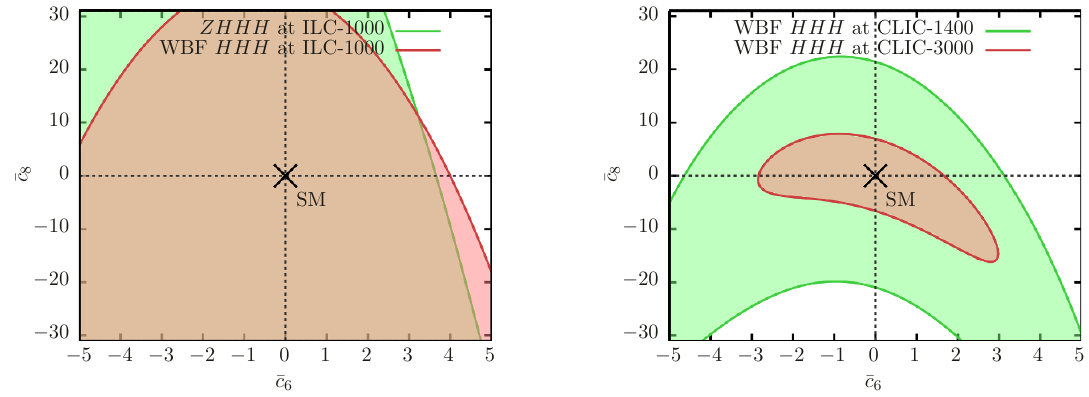
Figure 13 . 2 (cid:27) bounds in the ((cid:22) c 6 ; (cid:22) c 8 ) plane assuming SM cross sections in triple Higgs production in the Scenario 2 described in the text. Left: ZHHH and WBF HHH at ILC-1000. Right: WBF HHH at CLIC-1000 and